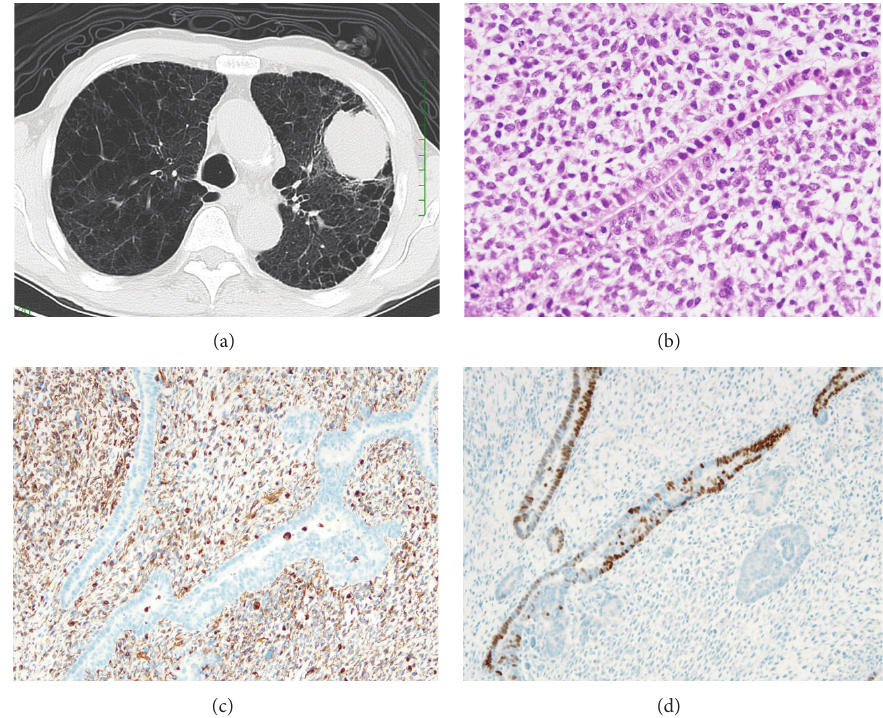
Figure 1: (a) Chest CT showing the mass opacity of the diameter 55 × 45mm in size in the left upper lobe. Severe emphysema is visible in the background. (b) Pathology (hematoxylin and eosin staining, 400x) shows a part of carcinoma with slit-formed duct formation of carcinoma and immature mesenchymal cells. (c) Vimentin (100x) is diffusely positive for the mesenchymal cells. (d) TTF-1 (100x) is positive in parts of carcinoma with the slit-formed duct